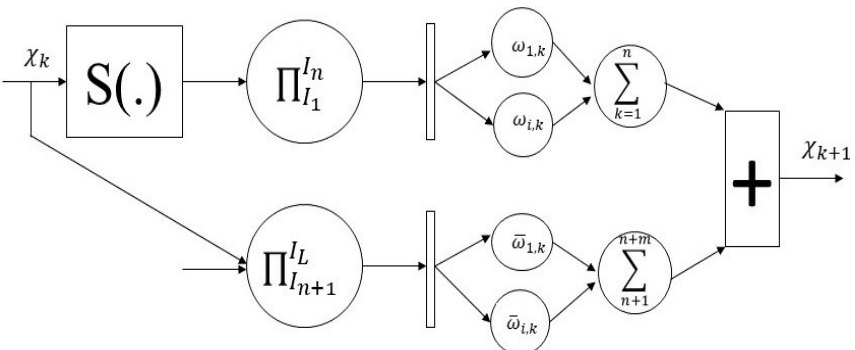
Figure 16. RHONN identifier